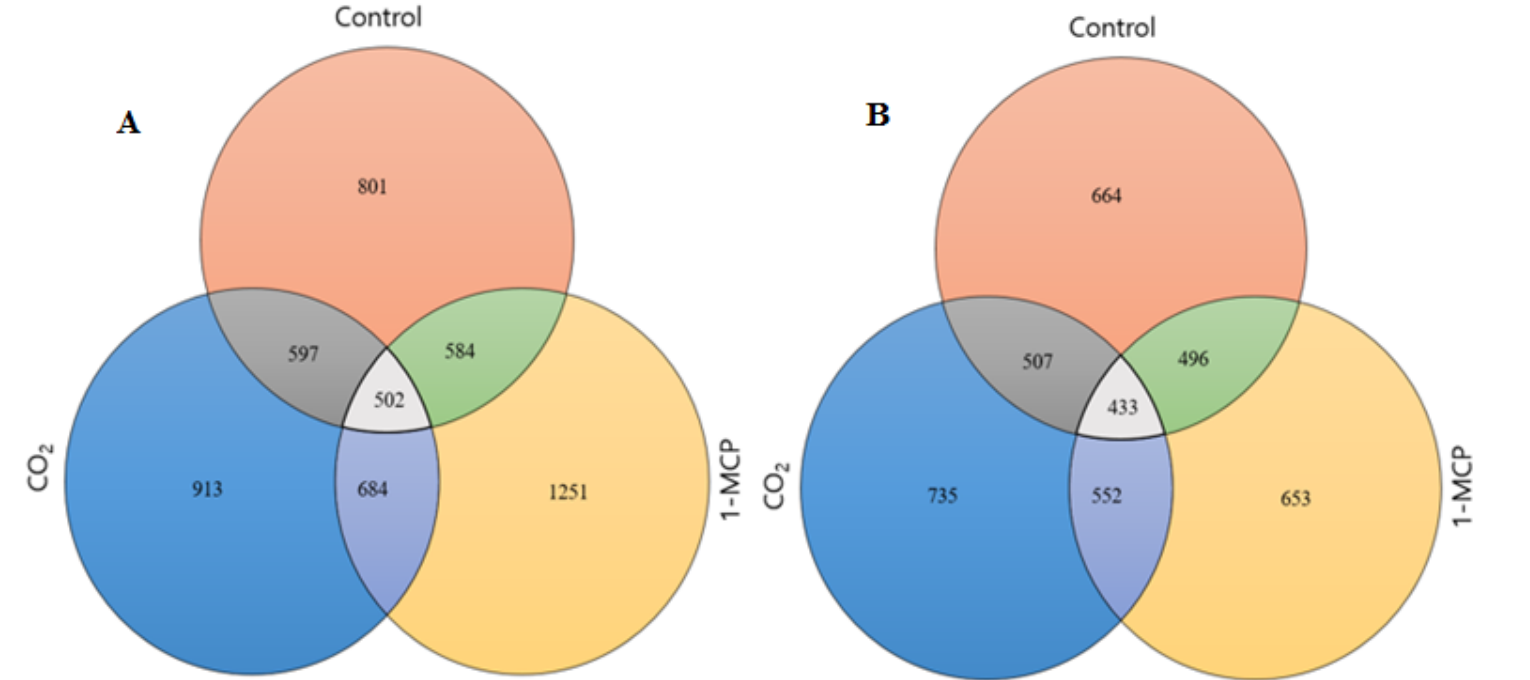
Figure 2. Numbers of commonly and exclusively expressed ( A ) upregulated and ( B ) downregulated genes based on twofold change and p -value < 0.05 during the comparison of control (control vs. CS), 1-MCP (control vs. 1-MCP+CS), and CO 2 (control vs. CO 2 +CS) ‘Madoka’ peach fruit after 12 days storage at 0 °C.